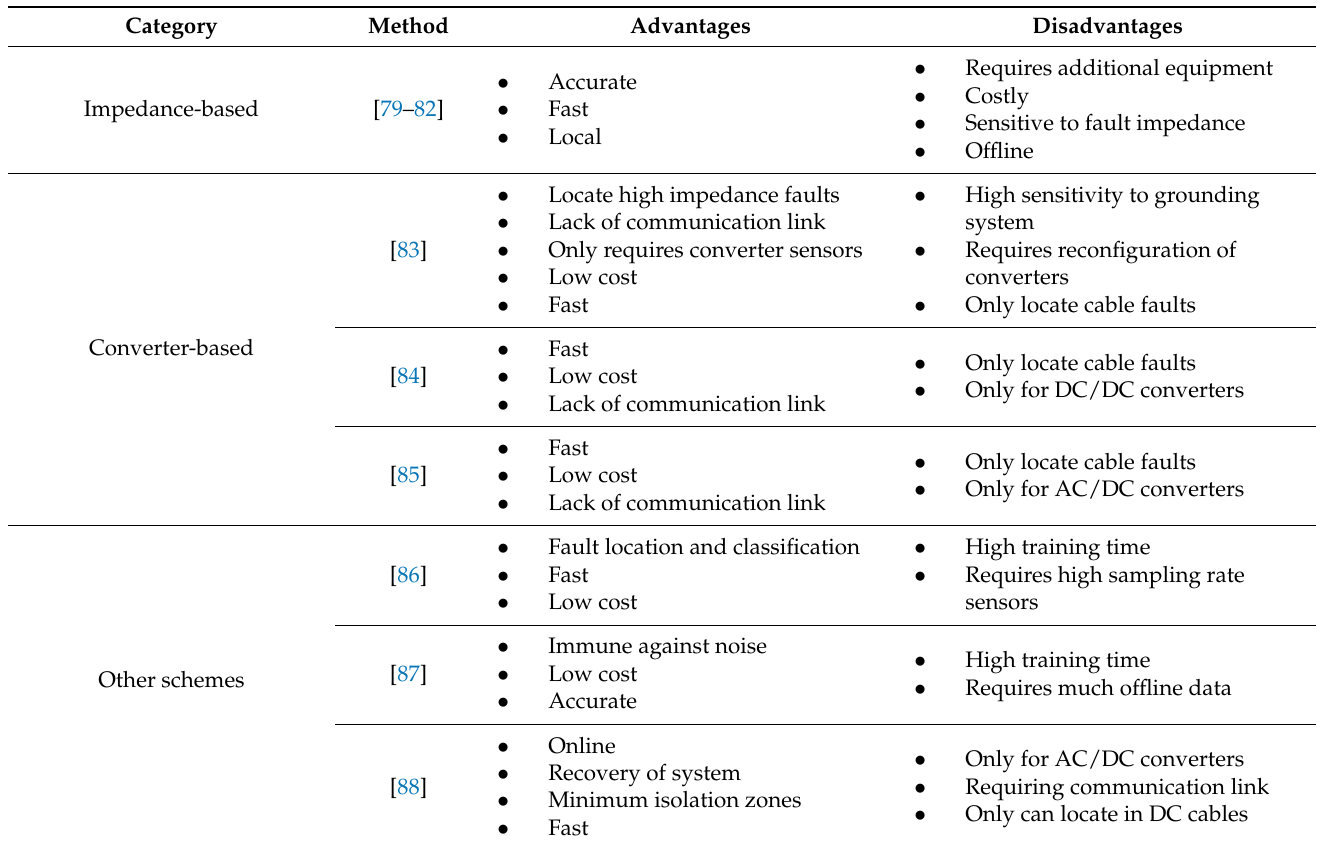
Table 4. Summary of fault location